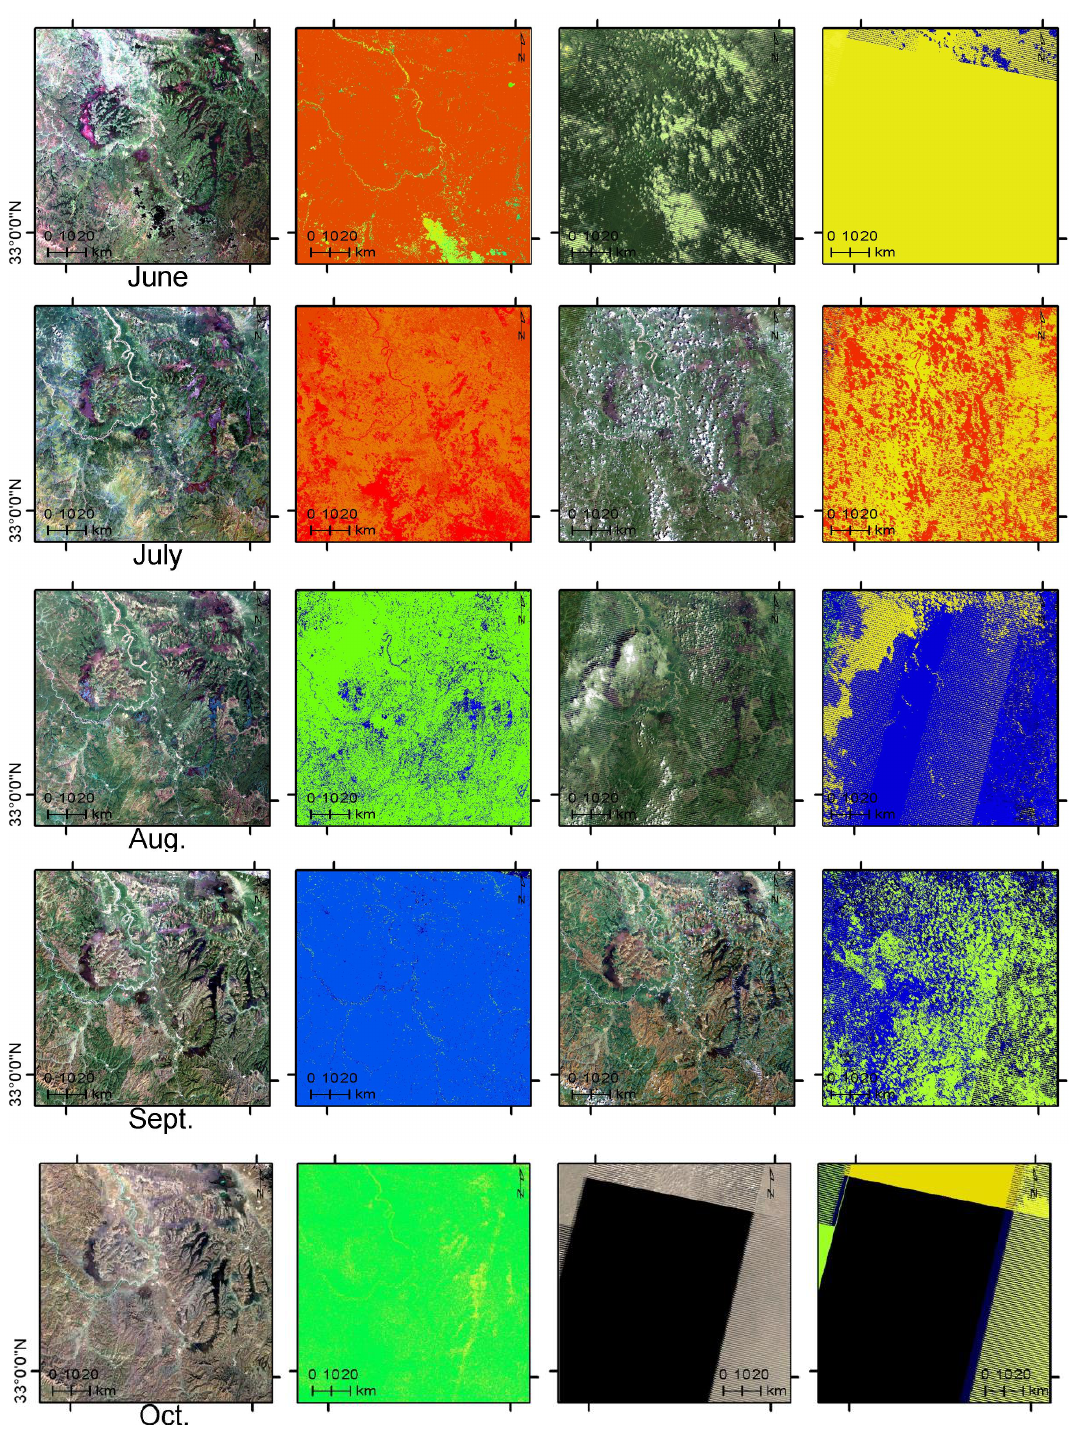
Figure 6. The visual consistency evaluation (from left to right): ( column 1 ) browse images of HJ-1A/B composites (true color); ( column 2 ) HJ corresponding DOY flag images; ( column 3 ) browse images of Landsat Web-Enabled Landsat Data (WELD) composites (true color); ( column 4 ) WELD corresponding DOY flag images. The black color in February and October in WELD represents no data pixels. “BOM” means beginning of month, and EOM means end of month. Statistics for the total observations considered in the compositing period were made for both HJ and WELD. For HJ composites, more than 67.21% pixels had 10 or more days of observations within the target month, whilst 26.61% pixels had 15 days or more of observations. About 65.14% of pixels were acquired within four days in the composites. For WELD, only 1.51% pixels had clear observations for all 12 months. The span of days between most WELD pixels ranged from seven days to 25 days. Particularly, about 25.14% of WELD pixels were acquired over more than 15 days. 4.2.2. Radiometric Consistency Assessment To test the radiometric consistency between HJ and WELD, scatterplots of all four bands were drawn for each month. Considering the limitations on space, Figure 7 shows the scatter plots for each middle month of the four seasons. The standard seasonal definition for the Northern Hemisphere adopted by the climate modeling community was used where spring is defined as the months from BOM EOMBOM